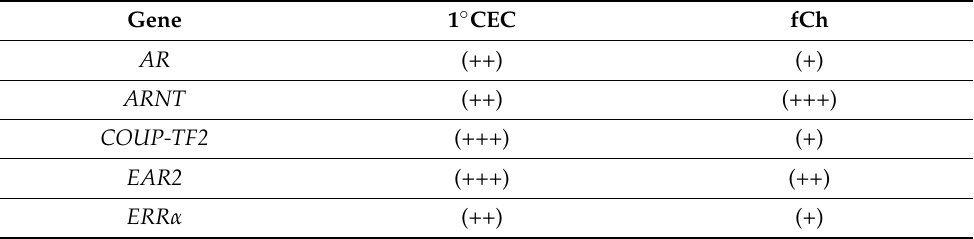
Figure 3. Nuclear receptor expression in human choroidal endothelial cells compared to the choroid and biological pathway analyses. ( A ) Venn diagram illustrates overlapping expression of nuclear receptors in primary choroidal endothelial cells (1° CEC) and freshly isolated choroidal endothelial cells (fCh). Diagram was made using Venny 2.1.0. ( B ) Gene Ontology analysis of 32 common nuclear receptors in the 1° CEC and fCh were significantly enriched in a number of pathways. Stacked bar graph shows % of genes in the pathway (red), − log10 p value of each category in green and number of genes next to each bar graph. Analysis was performed using the DAVID functional annotational tool with the Reactome database. Table 1. Differentially expressed genes in primary CECs and freshly isolated choroid. Differentially expressed genes in two models of human choroidal endothelium are presented. Normalized nuclear receptor mRNA expression levels were defined as absent if the Ct value was ≥ 35, low if the level was less than 0.75, medium if the level was between 0.75 and 1.0, and high if the level was greater than 1. Absent ( − ) Low (+) Medium (++) High